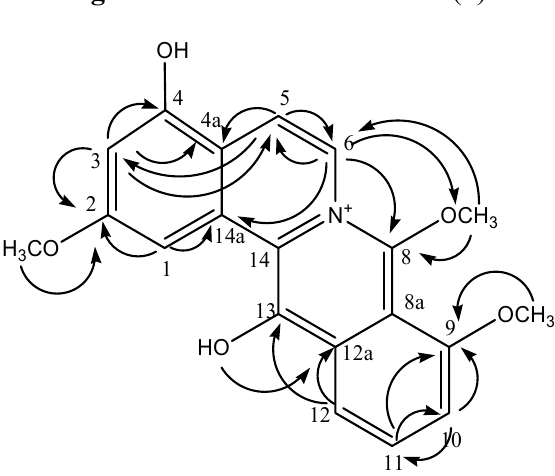
Figure 2. HMBC correlation of ( 1